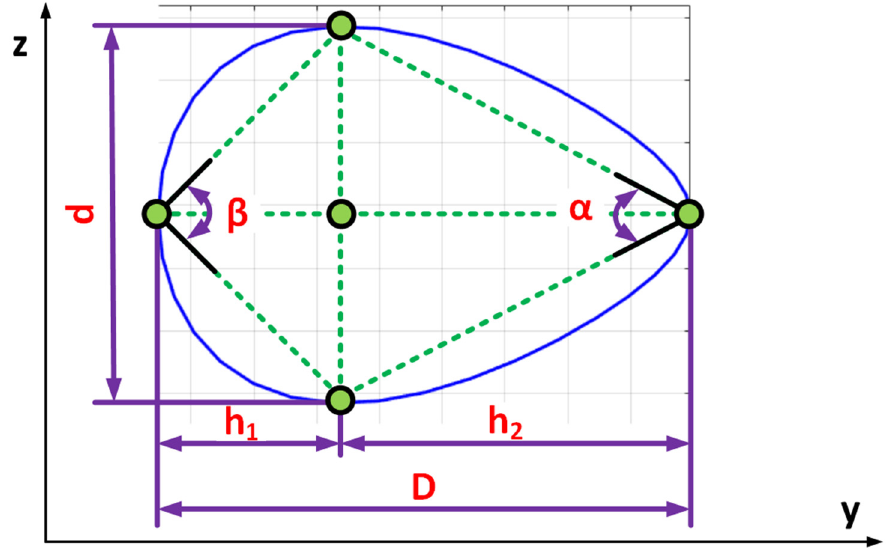
Figure 1. Egg contour and defined parameters.